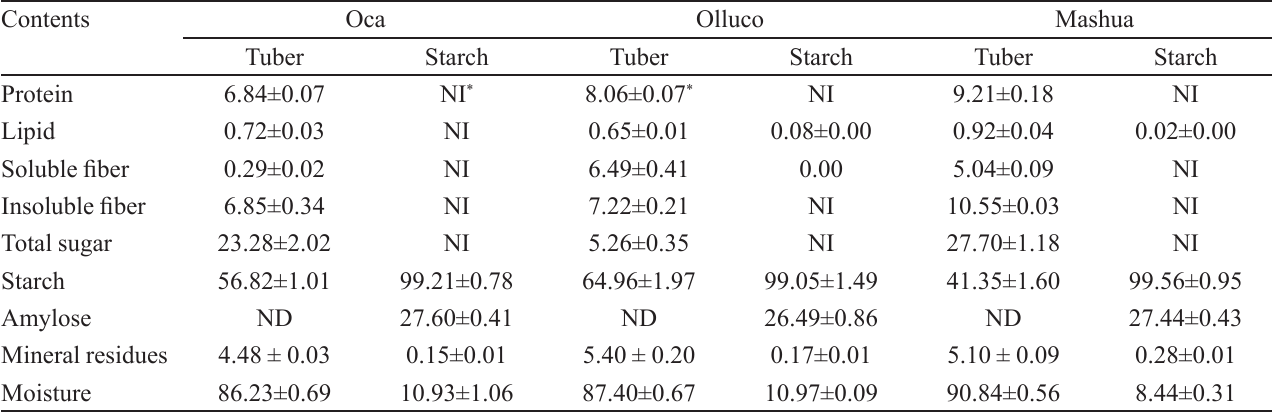
TABLE I - Chemical composition of tuberous starch sources and their respective starches (dry basis and initial moisture; %)